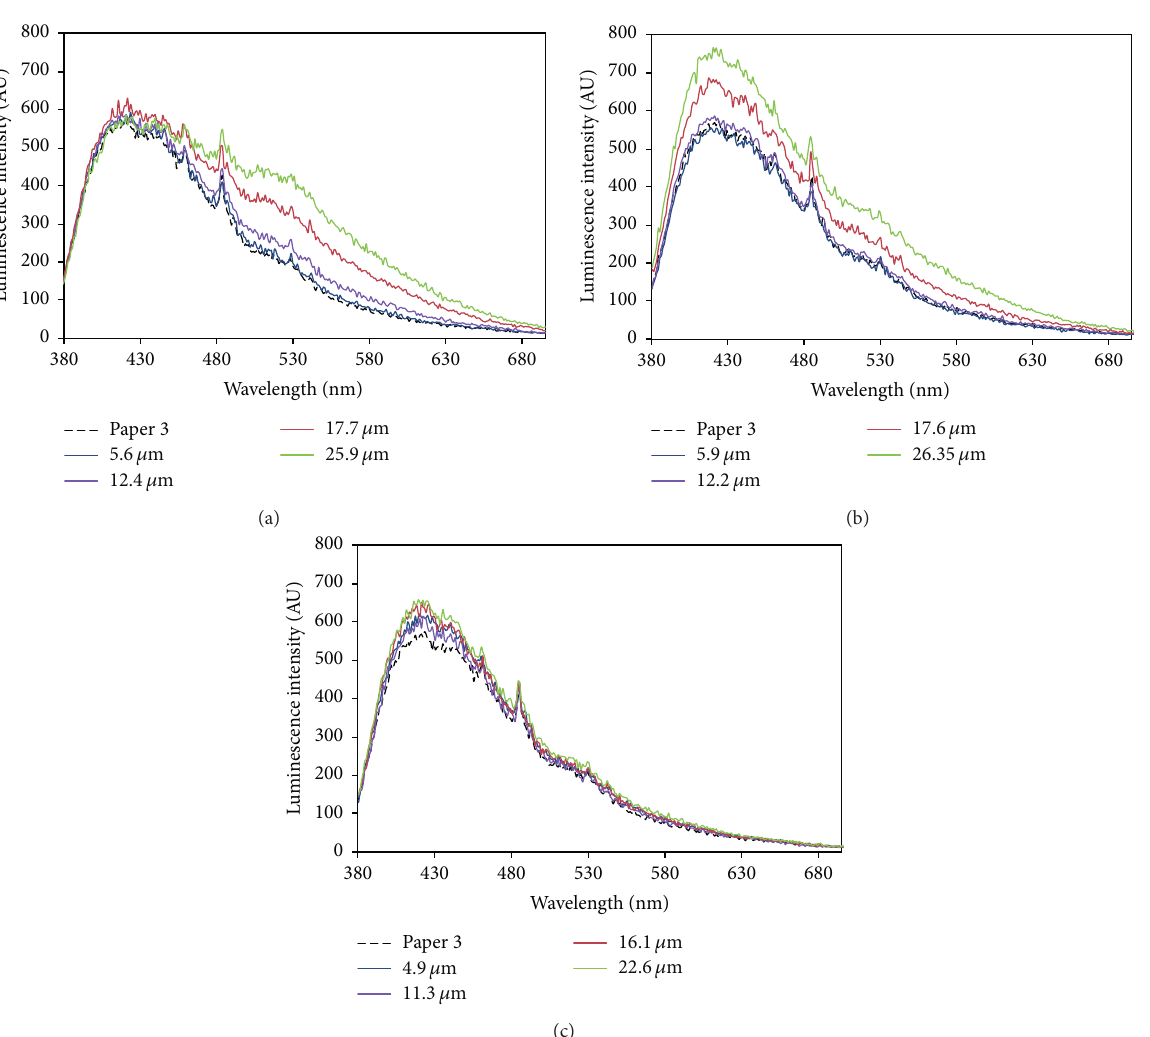
Figure 9: The dependency of the luminescence peak at 𝜆 = 430 (a) and 𝜆 = 520 nm (b) of printed impressions on paper with the medium content of OBAs (paper 2), obtained using ink compositions with different contents of the fluorescent component (ZnO nanoparticles), on ink layer thickness.